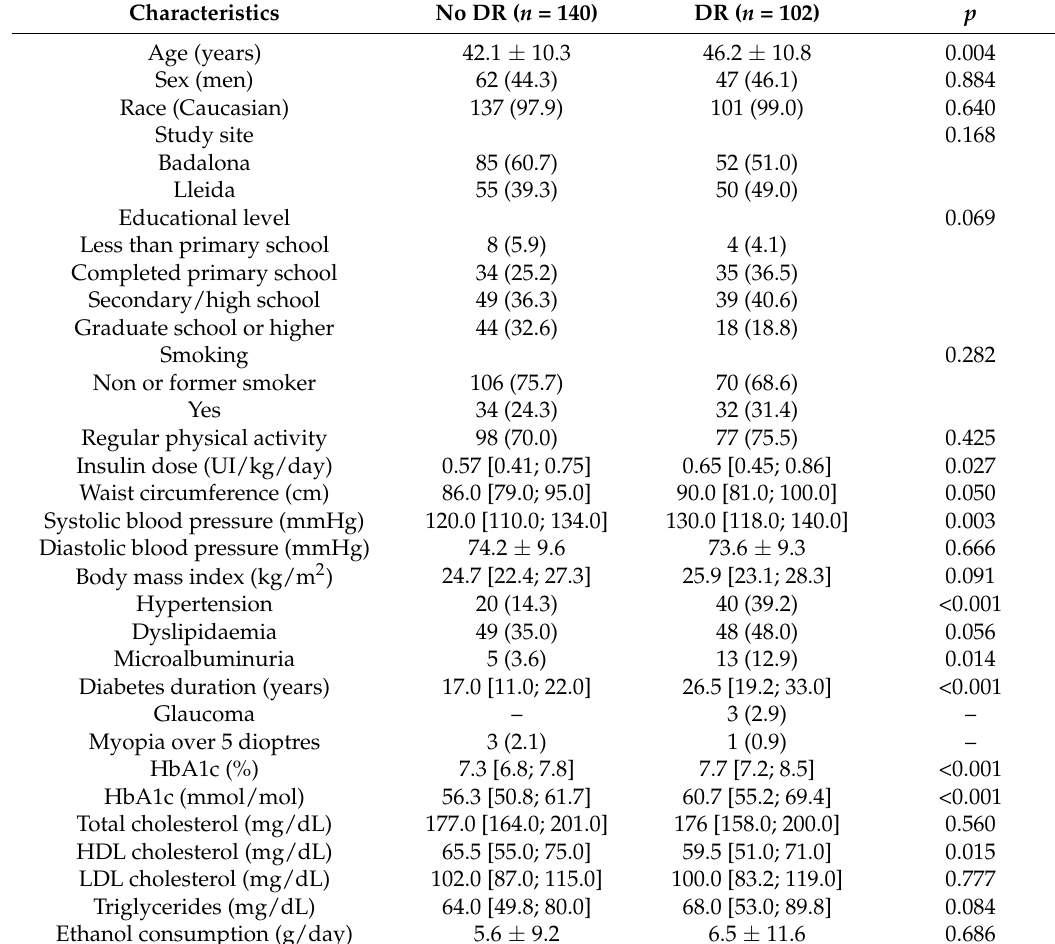
Table 1. Clinical and demographic characteristics of the study